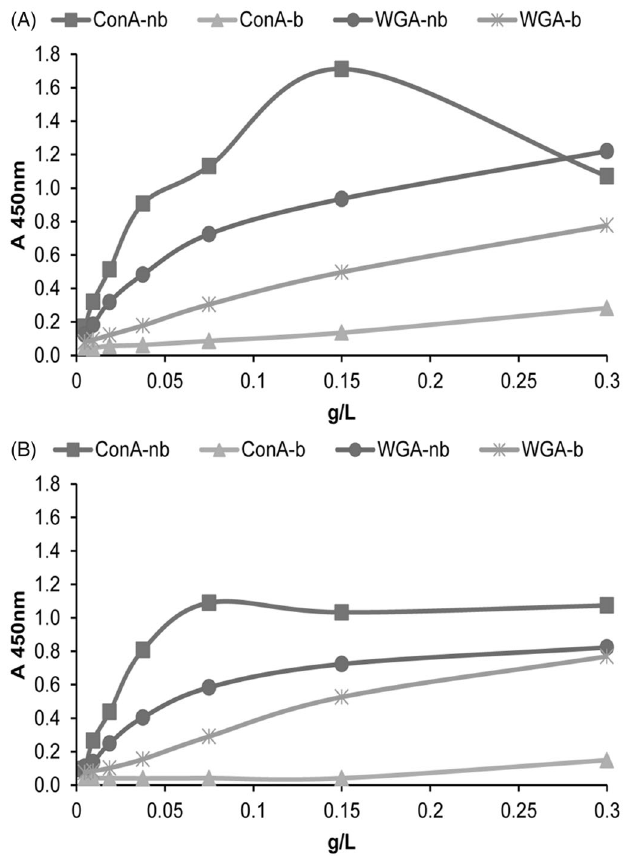
Figure 6. Surface glycosylation of seminal prostasomes from oligozoospermic men separated by lectin-affinity chromatography. LAC-separated fractions of seminal prostasomes from oligozoospermic men: Con A-non-bound (Con A-nb), Con A-bound (Con A-b), WGA-non-bound (WGA-nb), and WGA-bound (WGA-b) fractions were immobilized and re-probed with Con A (A) and WGA (B) by solid-phase binding